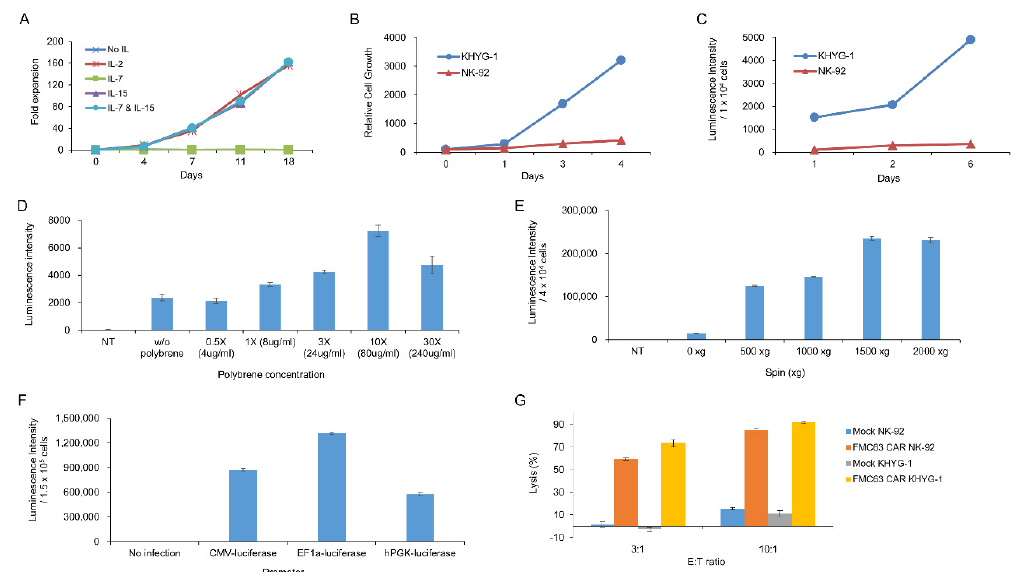
Figure 1. Biological characteristics of KHYG-1 cells used for CD19 single-chain variable fragment (scFv) screening. ( A ) The effect of cytokines, including IL-2, IL-7, and IL-15, on the proliferation of KHYG-1 cells was investigated. After adding IL-2, IL-7, IL-15, or IL-7 / IL-15 to the culture medium, proliferation of KHYG-1 was analyzed by cell counting. ( B ) Comparison of cell proliferation in KHYG-1 and NK-92. After KHYG-1 and NK-92 were cultured in each culture medium containing IL-2, proliferation was measured by a cell titer-glo assay. ( C ) Comparison of transduction efficiency in KHYG-1 and NK-92. After luciferase transduction to KHYG-1 and NK-92, luminescence value was detected by bright-glo assay for 6 days. ( D ) The effect of polybrene on transduction efficiency in KHYG-1. After luciferase transduction with different concentrations of polybrene into KHYG-1, luminescence was measured using a bright-glo assay on the 4th day. ( E ) KHYG-1 cells were infected with luciferase containing lentiviral particles with different g-values. After 5 days, luminescence was measured. ( F ) Comparison of gene expression by promoter type in KHYG-1. KHYG-1 cells were transduced with pLVX-CMV-Luc, pLVX-EF1 α -Luc, or pLVX-hPGK-Luc lentivirus. On day 4, intensity of luminescence was measured through a bright-glo assay. ( G ) Antigen-specific cytotoxicity of KHYG-1 and NK-92. Mock KHYG-1, FMC63 CAR KHYG-1, mock NK-92, or FMC63 CAR NK-92 cells (E:T ratio 3:1 or 10:1) were co-cultured with NALM-6 (1.5 × 10 4 cells), a CD19 positive cell line expressing luciferase, for 5 h. Then, luminescence values were